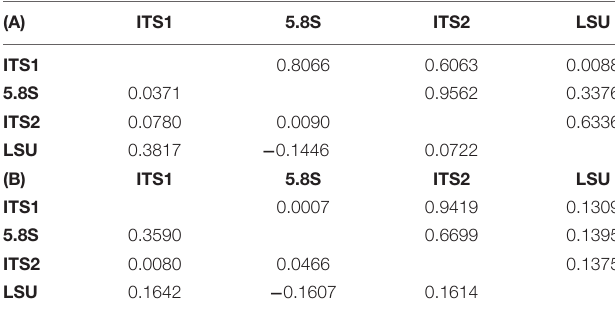
TABLE 2 | Correlation tables among the four loci sequences. Lower triangles report the correlations among the distances between the reference sequence and the consensus cloned (A) or the original (B)